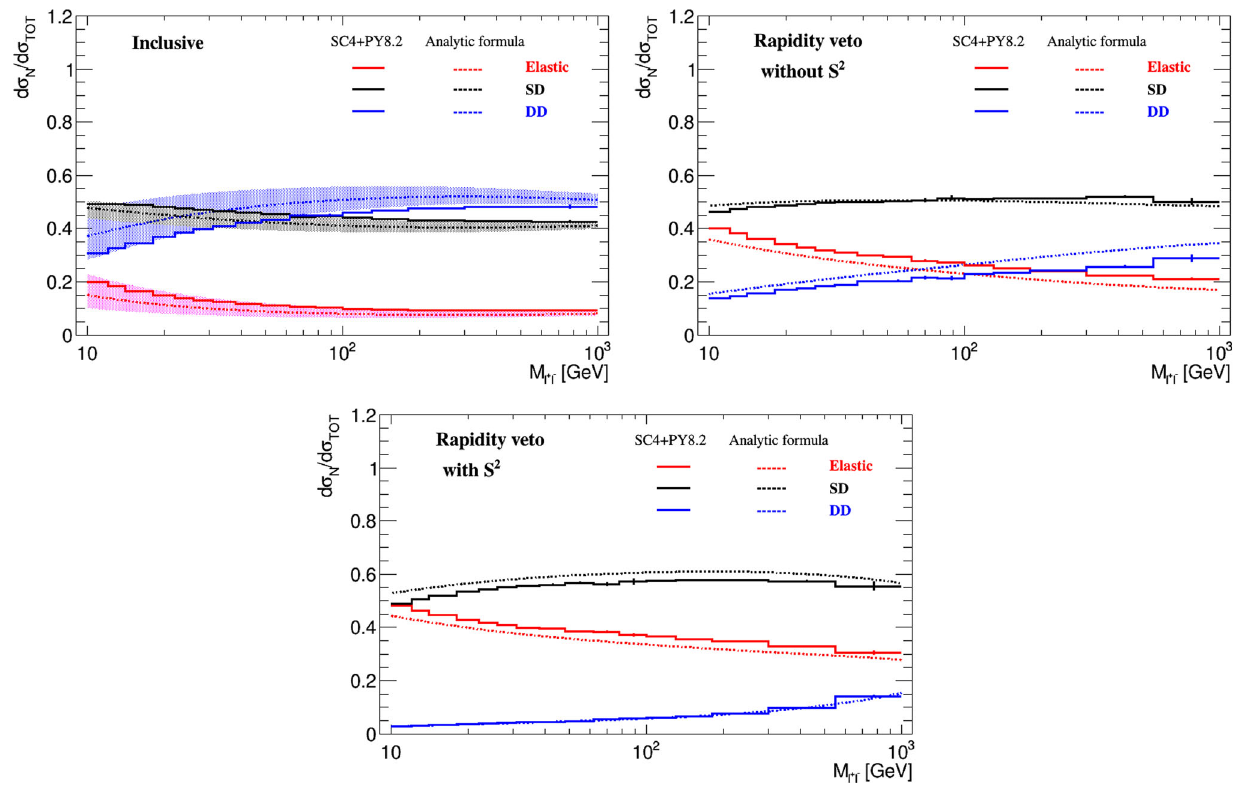
Fig. 2 Fractional cross section for elastic, SD and DD muon pair pro- the proton dissociation system alone in the | η | < 4 . 4 region, and after √ s = 13TeV,for including the survival factor from the MC. The analytic predictions duction,asafunctionofthedileptoninvariantmass,at p l ⊥ > 1 GeV and | η l | < 2 . 5. The very low p ⊥ cut is chosen purely for of [18], based on modified DGLAP evolution, are shown as dashed lines, with factor of μ F , R = μ 0 × ÷ 2 (with μ 0 = M ll ) scale variation display purposes, that is to reduce the impact of any kinematic effects of cuts at lower invariant mass. Results are shown for the inclusive case, bands given in the inclusive after imposing a rapidity veto on additional particle production from